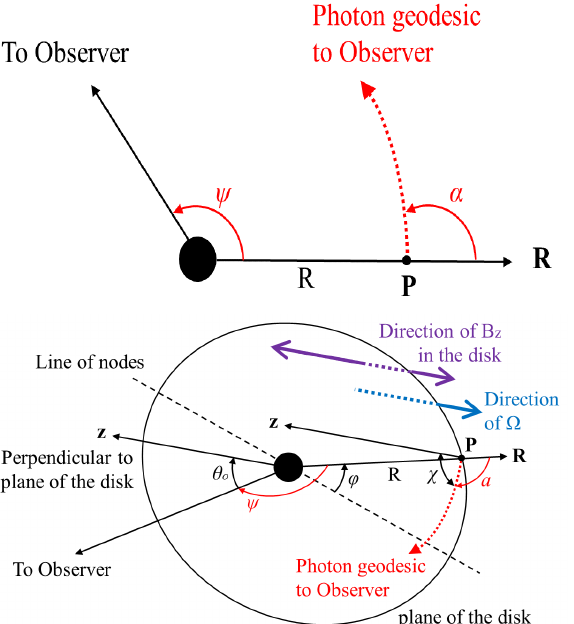
Figure 1. Top: angles ψ and α along the geodesic plane that is defined by the lines connecting the central black hole to the photon emitting point P at distance R , and to the EHT observer (same notation as in [14]); Bottom: 3D view of the geodesic plane in relation to the plane of the disk. θ o = 17 ◦ . φ is defined counter-clockwise from the line of nodes of the plane of the disk. Both Ω and B z lie along z . Notice that the z-direction perpendicular to the disk is drawn twice: at the position of the central black hole, and at the position of the photon emitting point P. The photon trajectory makes an angle χ with the vertical z-direction at its point of origin in the disk. As defined in this sketch, Ω < 0 for the particular viewing angle of M87 ∗ , and according to the Cosmic Battery prescription, B z < 0 inside R CB , and B z > 0 outside (as we noted in the text, the position of field reversal is not known; here, we have assumed for simplicity that it is at R CB = R CB ). The geodesic plane makes an angle ξ (not shown) with respect to the disk plane around the line connecting the central black hole to the photon emitting point P.